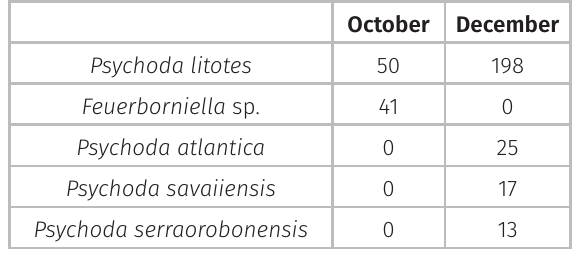
Table I. Diversity of moth flies collected with oviposition traps in 2016.